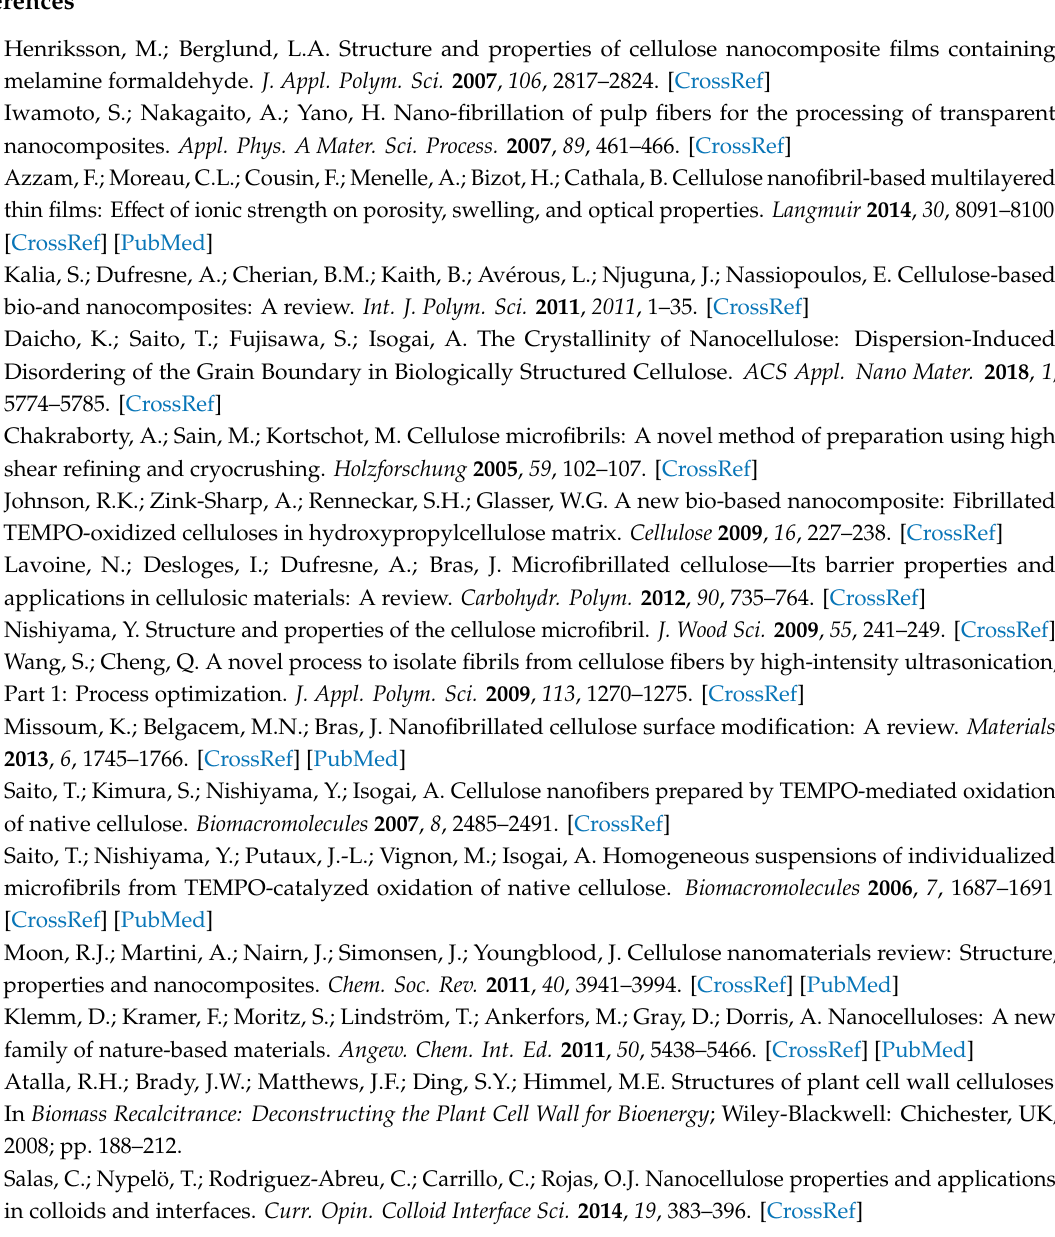
Supplementary Materials: The following are available online, Figure S1: Schematics for the multilayered samples of nanocellulose coatings on the surface of polymer materials according to Protocols 1–4, Figure S2: Structure of the P(GMA-OEGMA) copolymer, Figure S3: Pore size distribution of cotton fabrics, Figure S4: Pore size distribution of nylon fabrics, Figure S5: Pore size distribution of cotton / polyester fabrics, Figure S6: Pore size distribution of polyester fabrics, Figure S7: FT-IR spectra of (a) cotton-NCC and cotton-NCC treated with MA and (b) cotton-NFC and cotton- NFC treated with MA, Figure S8: AFM topography image of the cellulose coating on the Si-wafer after the scratch with a steel needle, Figure S9: Schematic of a sample for the T-peel